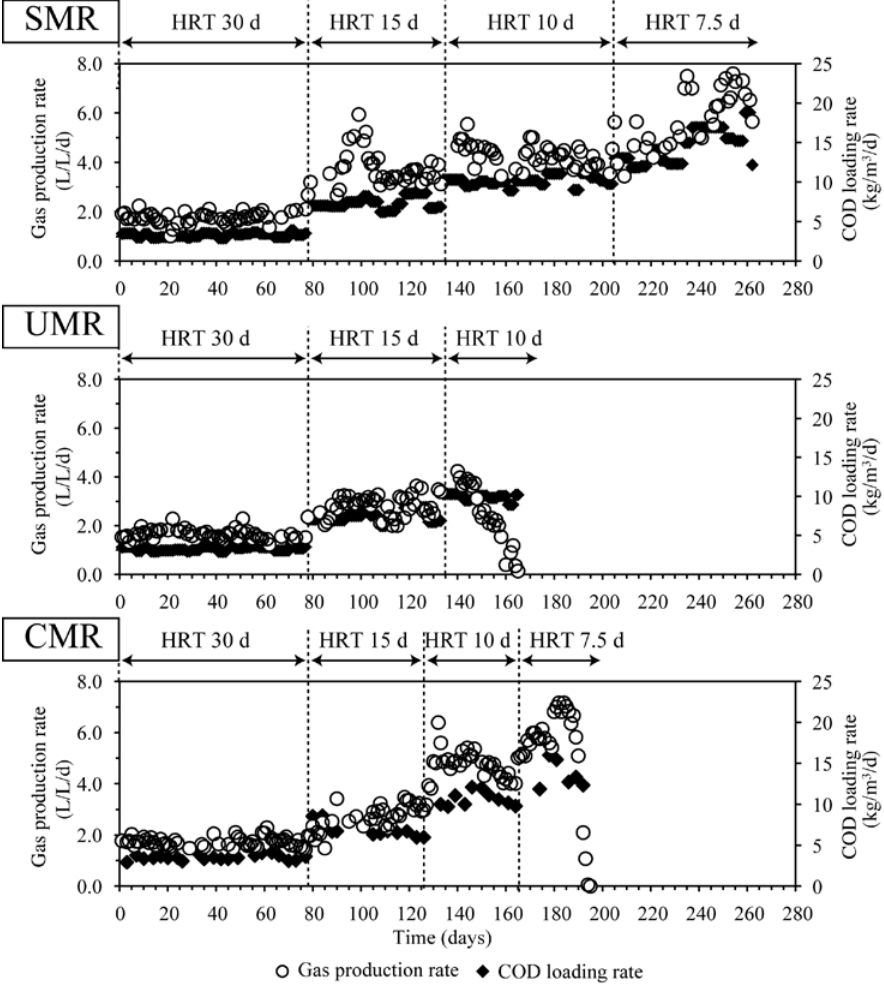
Figure 1. Time course of HRT, OLR and the biogas production